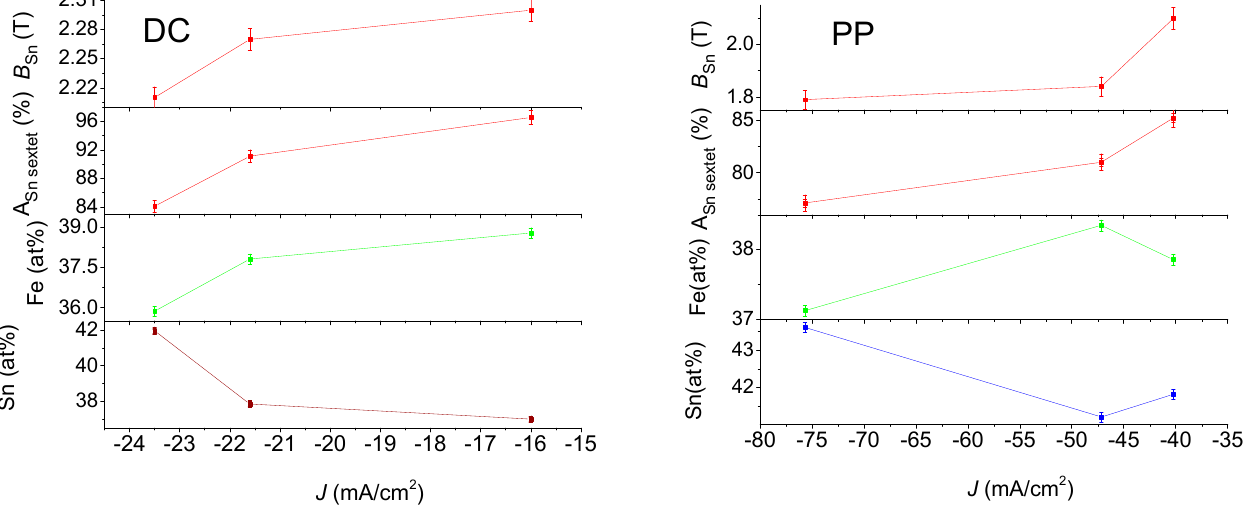
Figure 8. 57 Fe conversion electron Mössbauer DATA of DC (on the ( right )) and PP (on the ( left )) electrodeposited quaternary Sn-Fe-Ni-Co alloy coatings together with Sn content with the current densities.